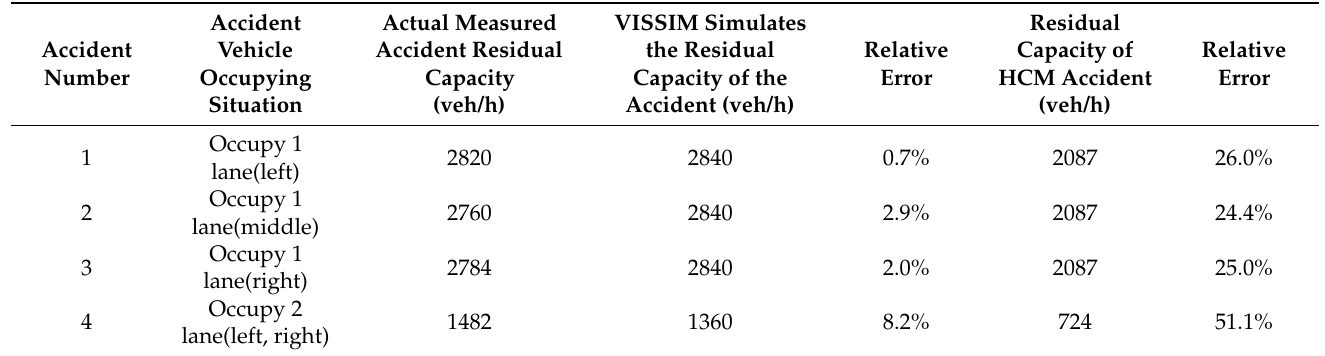
Table 1. Comparison of residual capacity of the accident section.